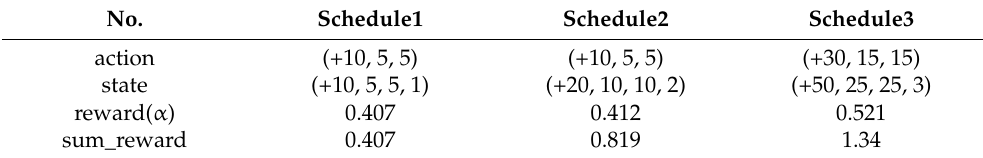
Table 4. Electric fence scheduling strategy based on reinforcement learning during weekends.